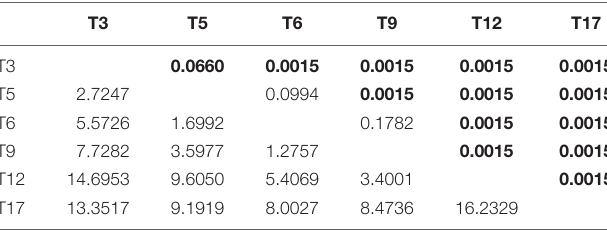
TABLE 4 | Pairwise PERMANOVA of global DNA methylation patterns between time